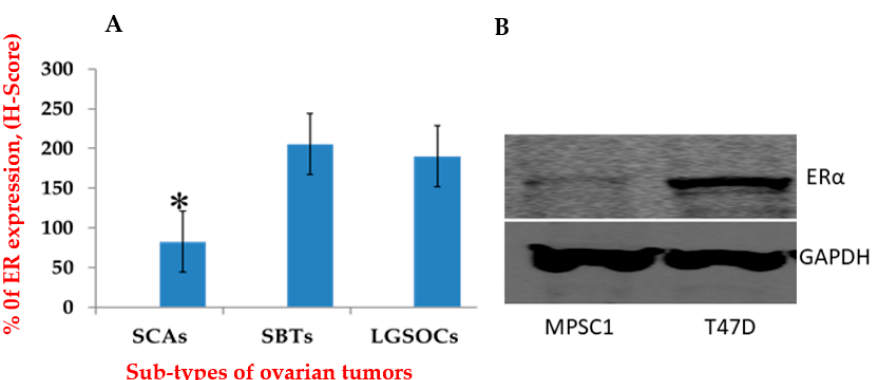
Figure 2. ER expression levels in ovarian serous tumors and MPSC1 cells. ( A ) ER expression levels in SCAs, SBTs, and LGSOCs. The expression level of ER in SBTs and LGSOCs is significantly (* p < 0.05) higher than that in SCAs; however, ER expression variation was not significant between SBTs and LGSOCs. ( B ) ER expression by Western blotting in MPSC1 and T47D cells. Uncropped Western Blot of ER α expression and a bar graph of Western Blot analysis we can be found at Figure S2. ER, estrogen receptor; SCAs, serous cystadenomas; SBTs, serous borderline